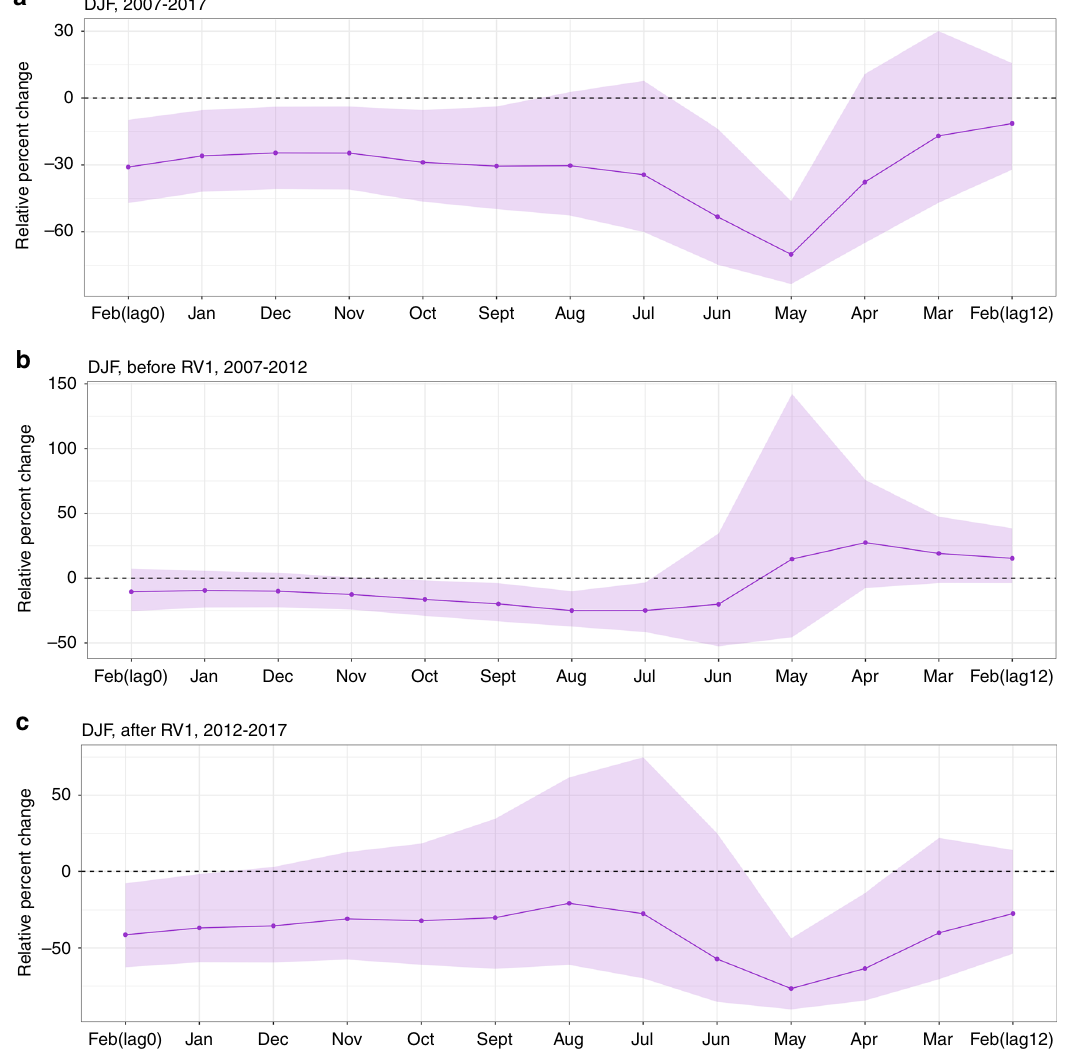
Fig. 4 Associations between DJF Niño 3.4 and under-5 diarrhea. December, January, February under-5 diarrhea associations with Niño 3.4 SST anomalies. The y -axis shows the estimated percent change and 95% con fi dence intervals in DJF diarrhea incidence associated with 1 K increase in Niño 3.4 SST anomalies. The x -axis represents the month of Niño 3.4 predictor, which is during or before DJF. Estimates are shown using ( a ) all of the data (2007 – 2017), ( b ) only data collected before the rotavirus vaccine rollout (December 2007 – February 2012), and ( c ) only data collected after the